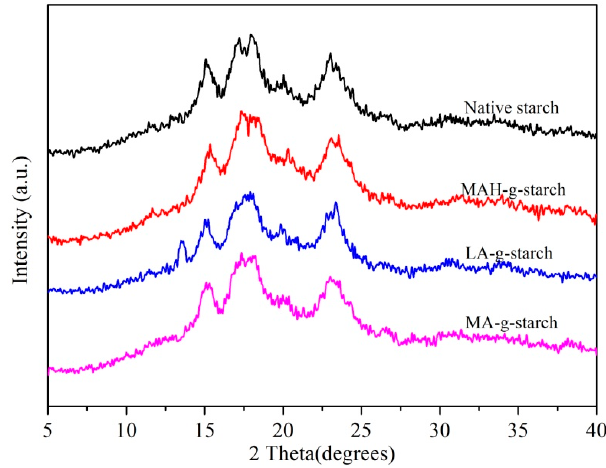
Figure 7. XRD diffraction patterns of native starch and grafted starch.